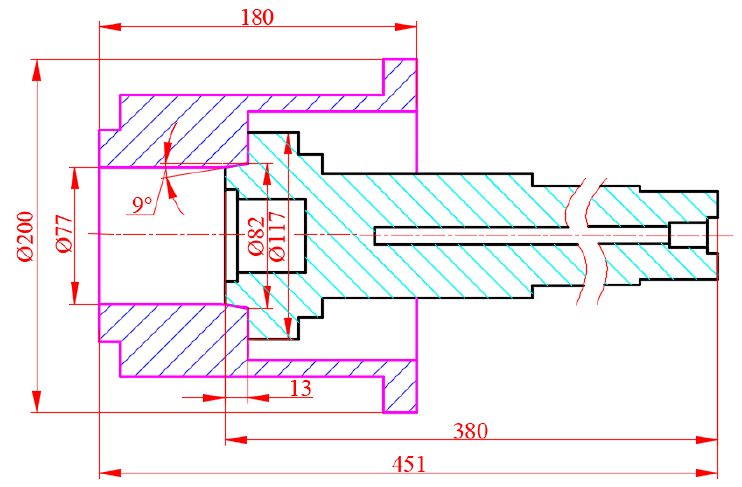
Figure 6. Structure parameters of the spindle and GWF.